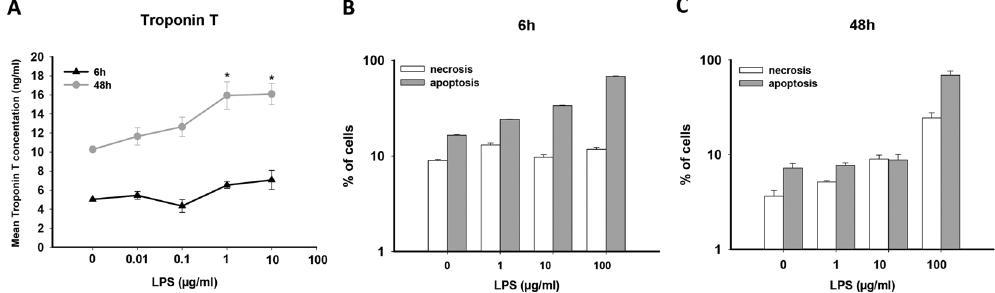
Figure 3. LPS induced cell impairment. ( A ) ELISA analysis showing that 48 h-but not 6 h-treatment with LPS increased concentrations of human Troponin T (TNNT) in s upernatants of LPS-treated hiPSC-CMs. p -values (test for linear trend): 6 h > 0.05, 48 h < 0.05. ( B , C ) FACS analysis for necrosis (7AAD positive) and apoptosis (Annexin-V positive) ratio of hiPS-CMs treated by LPS in different concentrations for 6 and 48 hours. 6 h-treatment showed a dose dependent increase of apoptotic cells ratio, but no influence on necrotic ratio ( B ). 48 h-treatment showed a dose dependent increase of necrotic cells ratio ( C ). The increase in apoptotic ratio was observed only when LPS concentration was raised to 100 µ g/ml ( p < 0.001 vs. 0 µ g/ml). Test for linear trend: 6 h, necrosis, p > 0.05, apoptosis, p < 0.001; 48 h, necrosis, p =